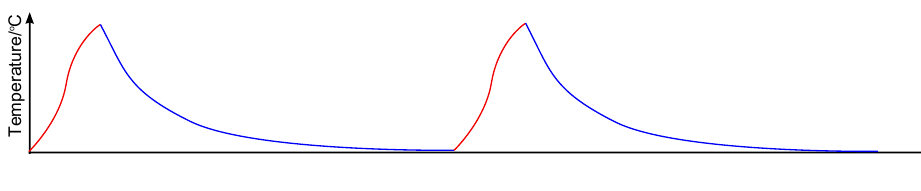
Figure 1. Periodical wireless charging